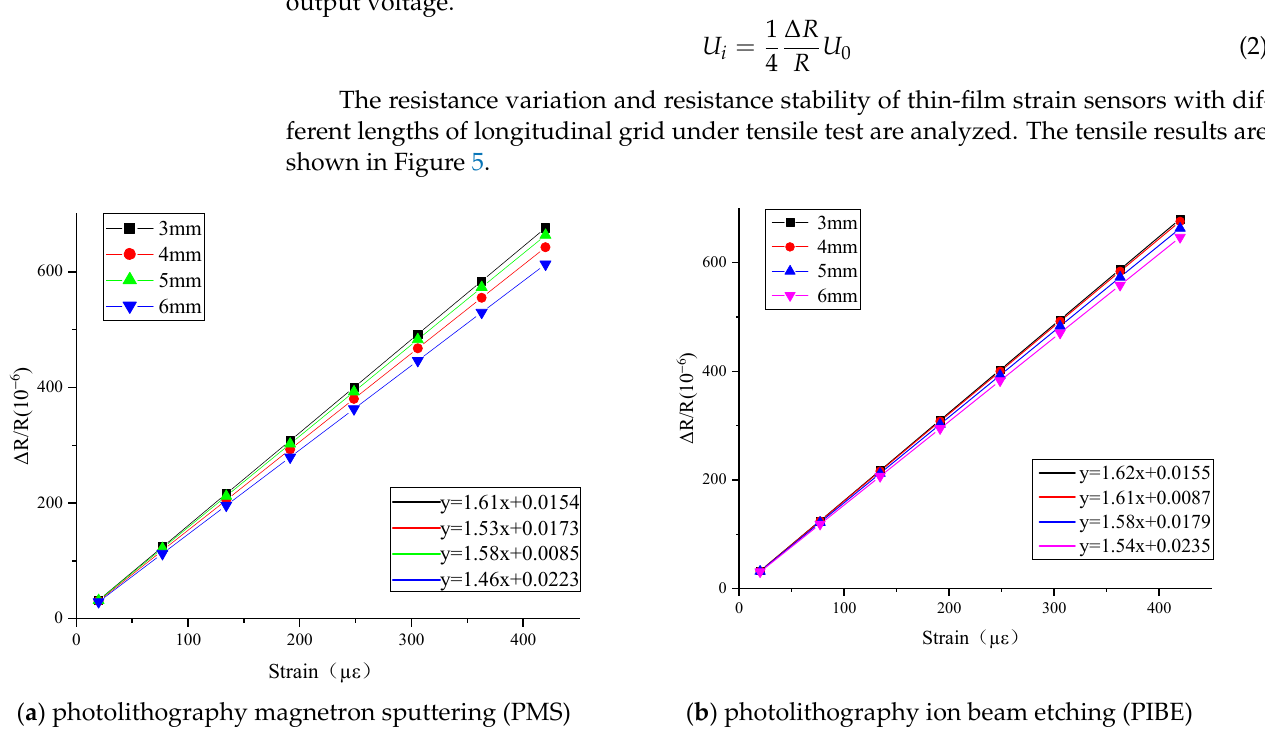
Figure 5. Tensile results of different grid lengths prepared by PMS and PIBE.